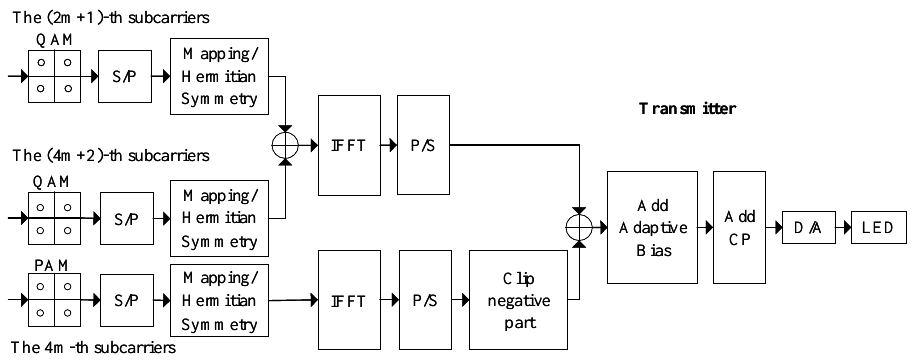
Figure 1. Block diagram structure of the transmitter of the proposed HABO-OFDM